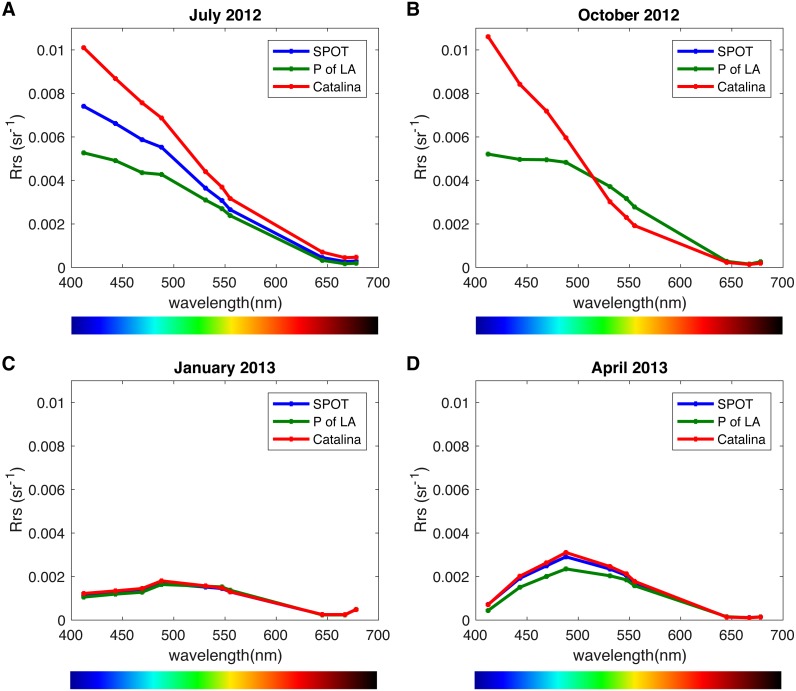
Remote sensing reflectance spectra (Rrs) per location and season.(A) July 16, 2012, (B) October 19, 2012, (C) January 10, 2012, (D) April 25, 2013. Measurements were taken the day after sampling day due to satellite data availability, with the exception of October for which there was data from the actual sampling day.